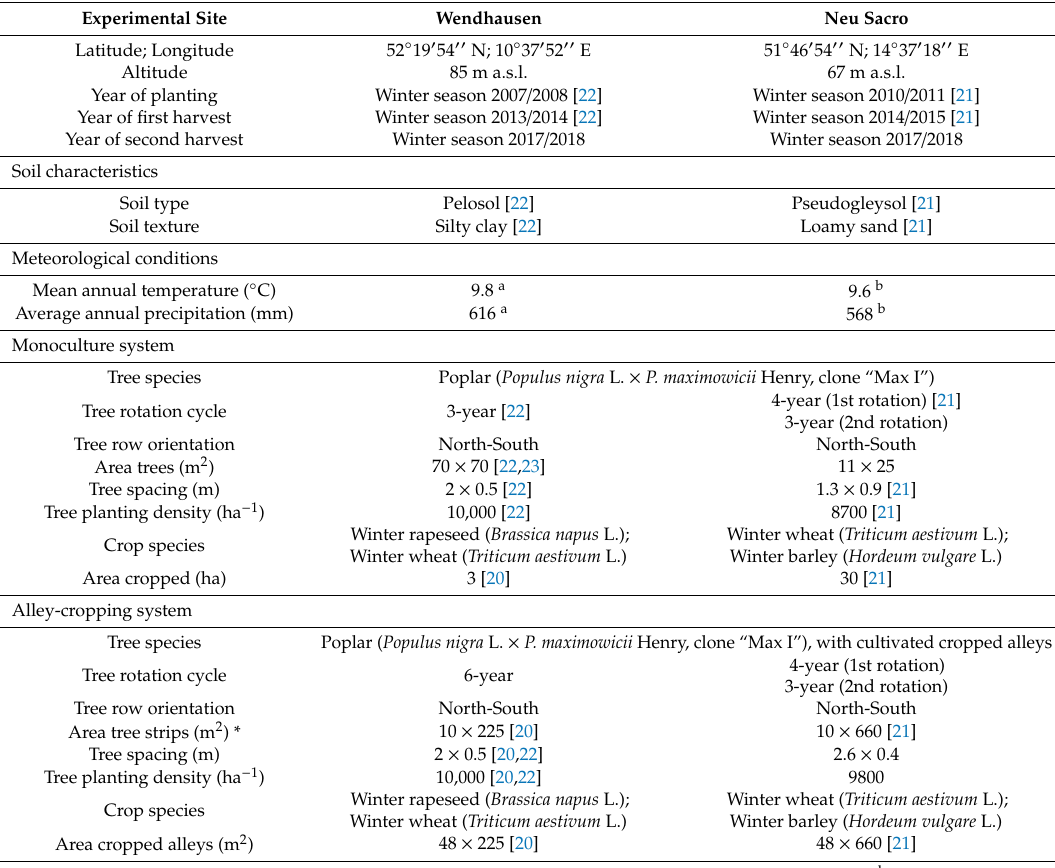
Table 1. Description of the experimental sites at Wendhausen and Neu